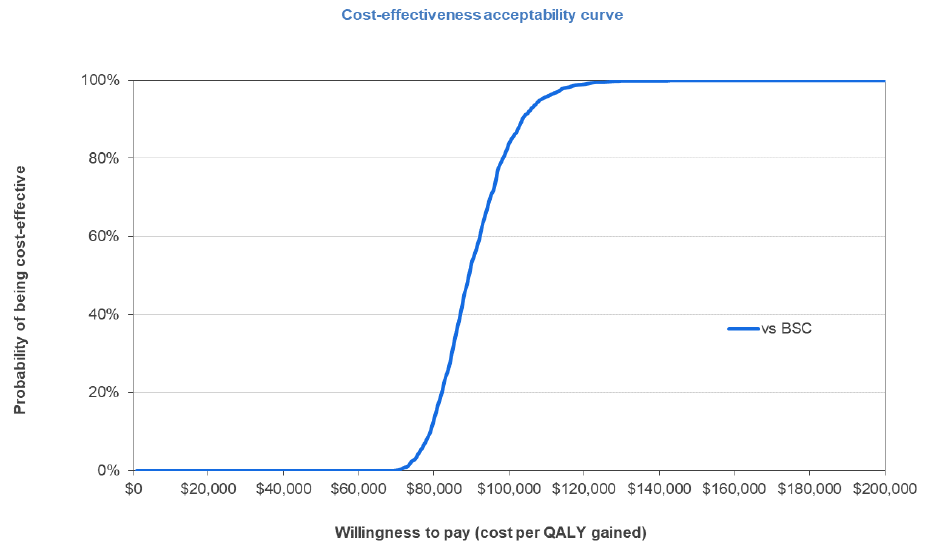
Figure 2. Cost-utility acceptability curve of 1000 simulations. Abbreviations: BSC, best supportive care; QALY, quality-adjusted life year.